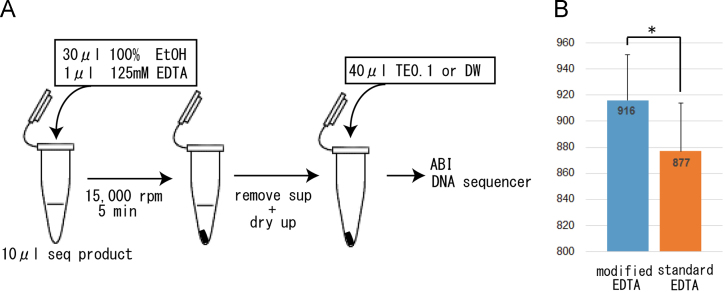
(A) Method for the single-step purification of dye-labeled sequencing products is described in left half. (B) Comparison of the sequence read lengths with QV>20 in two different methods is shown in right graph. Results are shown as the means±standard deviations (Student t tests; ∗P<0.01).